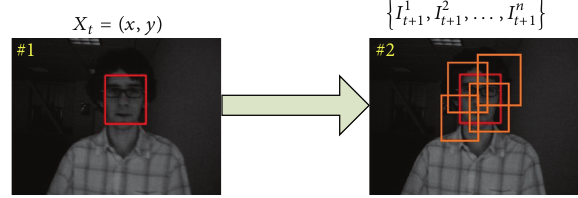
Figure 3: Image set via affine